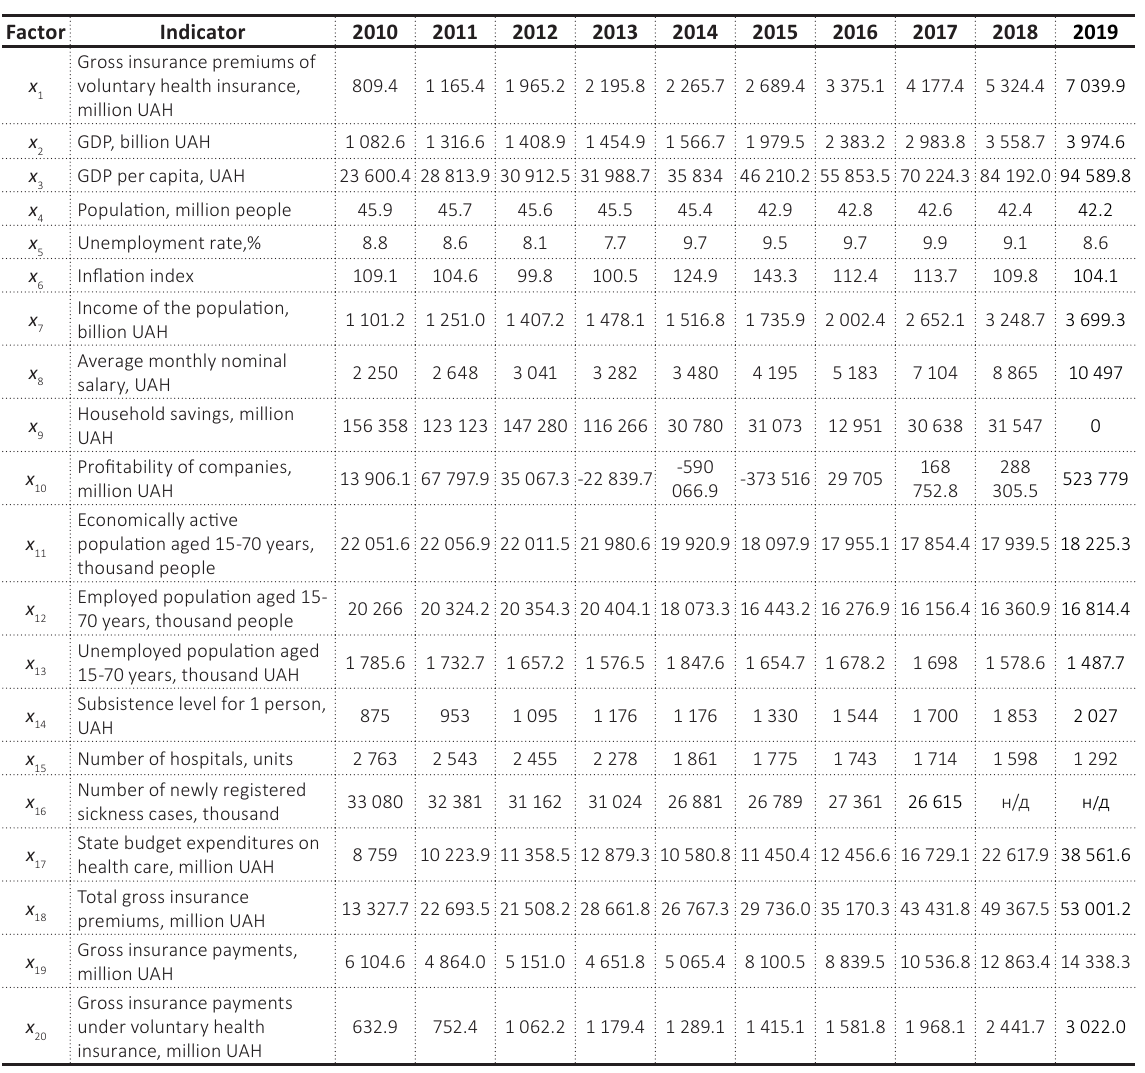
Table B1. Data for the study of capacity of the voluntary health insurance